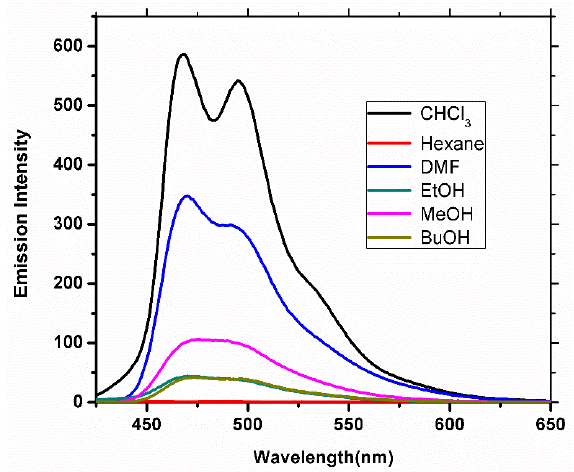
Figure 3: Emission spectra of PBA (20µM) in different